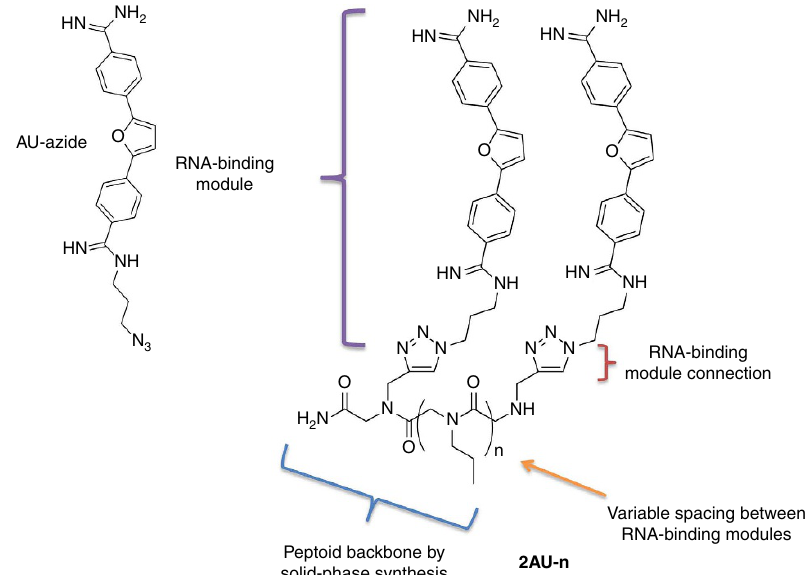
Figure 6 | Design of dimeric compounds to target r(AUUCU) exp . The RNA-binding module, AU-Azide (left) was assembled onto various peptoid backbones to afford dimeric compounds (right). The AU-azides were separated by different distances by varying the number of spacing modules (n) to generate a series of compounds named 2AU-n , where 2AU denotes two RNA-binding modules and n denotes the number of spacing